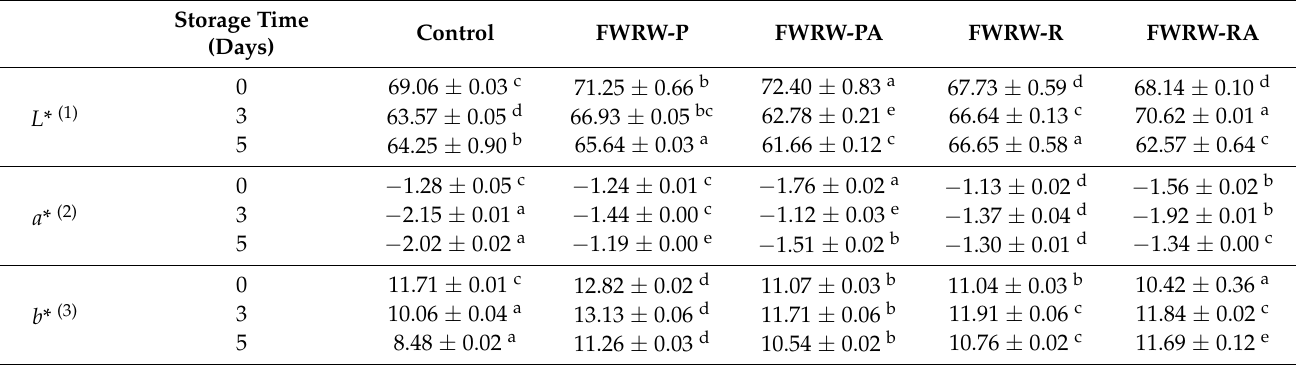
Table 3. Comparison of the color changes of garaetteok under various FWRW treatments and storage